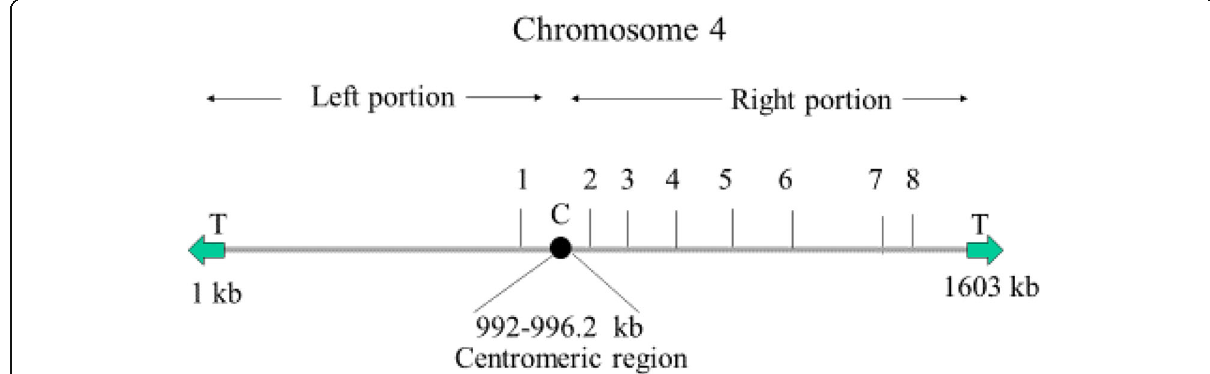
Fig. 4 The schematic diagram of eight truncations on chromosome 4 (1603 kb long). Truncation 1 at 969.925 kb position on the left side of the centromere. Truncations 2 – 8 at 1002.852 kb, 1102.087 kb, 1201.989 kb, 1301.783 kb, 1369.883 kb, 1529.969 kb, and 1542.907 kb positions on the right portion of Chr4. The centromere spanned at 992 – 996.2 kb position according to Candida Genome